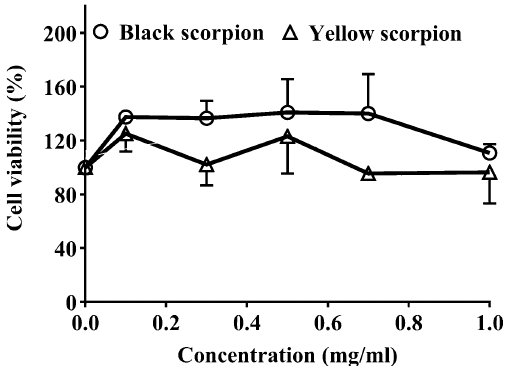
Figure 1. Cytotoxic effect of crude scorpion venom on CRC cell line. The cell viability after treatment for 24hrs on the HT-29 CRC cell line with Hottentotta Saulcyi scorpion venom (Black scorpion) and Androctonus Crassicauda scorpion venom (yellow scorpion),